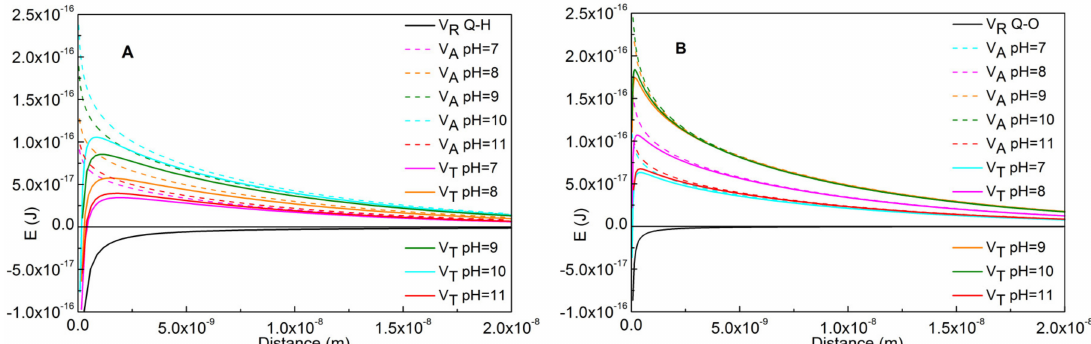
Figure 10. Relationship between interaction energy of impurities with quartz and particles distance at different pH; ( A ) is the relationship of hematite with quartz; ( B ) is the relationship of orthoclase with